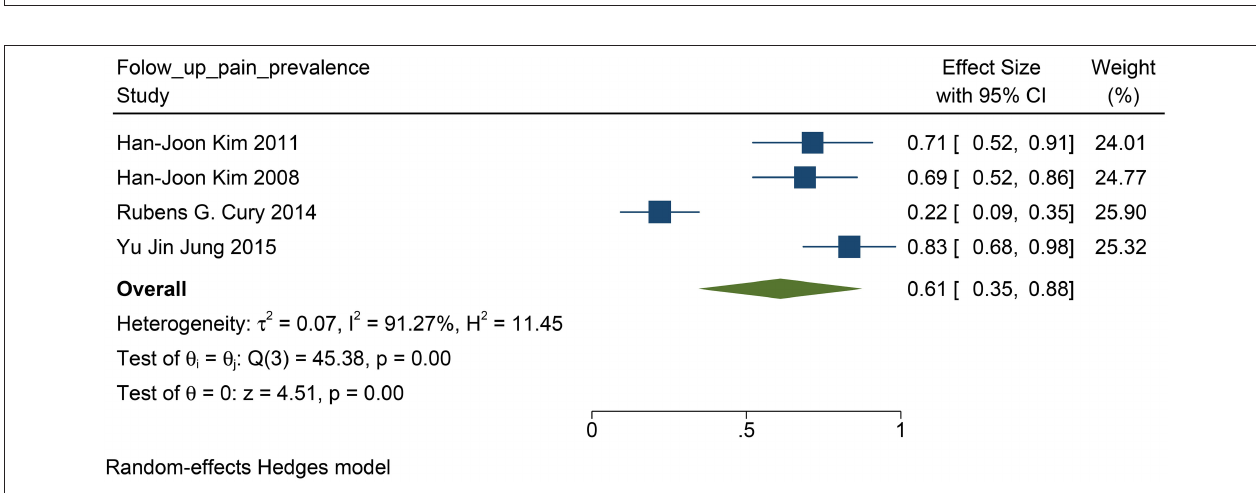
FIGURE 6 | The pain prevalence in patients with PD at baseline: the pain prevalence in patients with PD at baseline is 76%. PD, Parkinson’s disease.